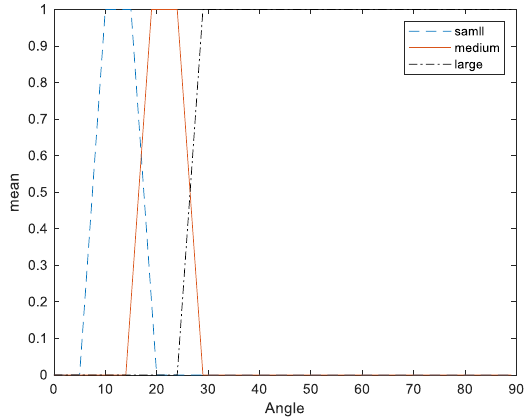
Figure 13. A typical architecture of fuzzy logic control. 3.5.1